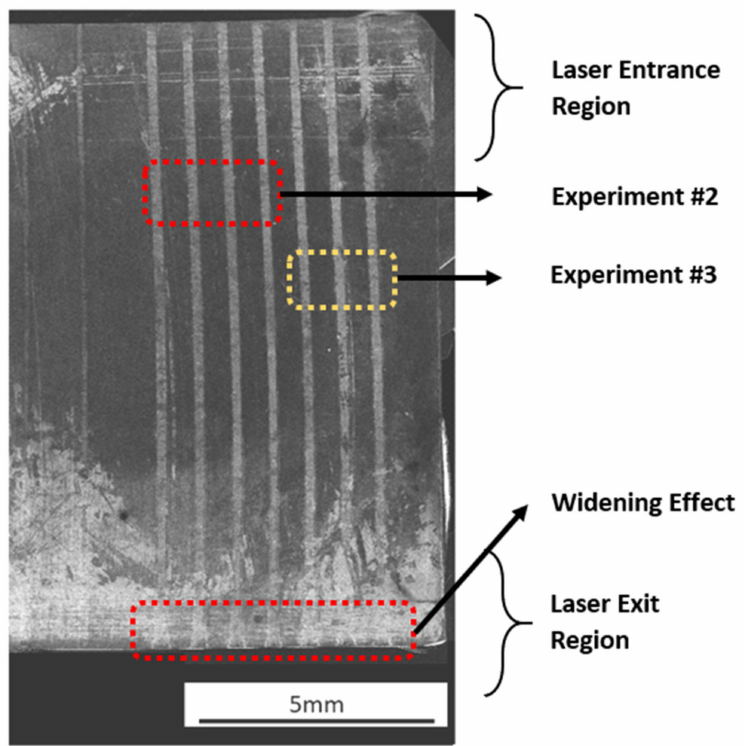
Figure 9. Entrance Exit SEM for the experiments with Ce addition #2 and #3. Compared to the middle section, entrance and exit region of the laser get widen due to the lack of conduction body. Stability of the melt pools can be understood whether they tend to expand or shrink. In this scenario, there is no clear expansion or shrinkage trend